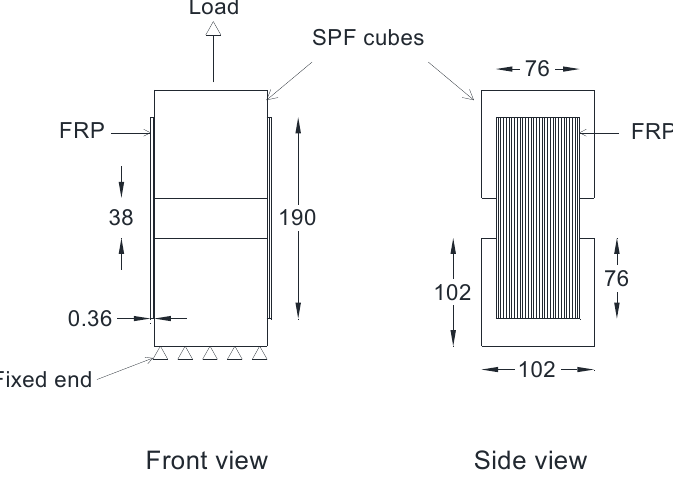
Figure 2. Setup for double lap shear test (all dimensions are in mm).